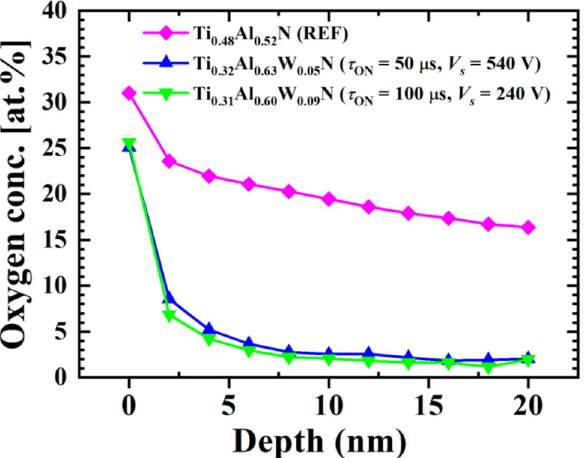
Figure 6. The oxygen concentration depth profiles obtained from XPS for Ti 0.32 Al 0.63 W 0.05 N (50 μs, 540 V), Ti 0.31 Al 0.60 W 0.09 N (100 μs, 240 V), and the reference Ti 0.48 Al 0.52 N layer. The absolute numbers are overestimated (as compared to the results of ToF-ERDA analyses) due to the artefacts introduced by ion etching and oxygen redeposition on the